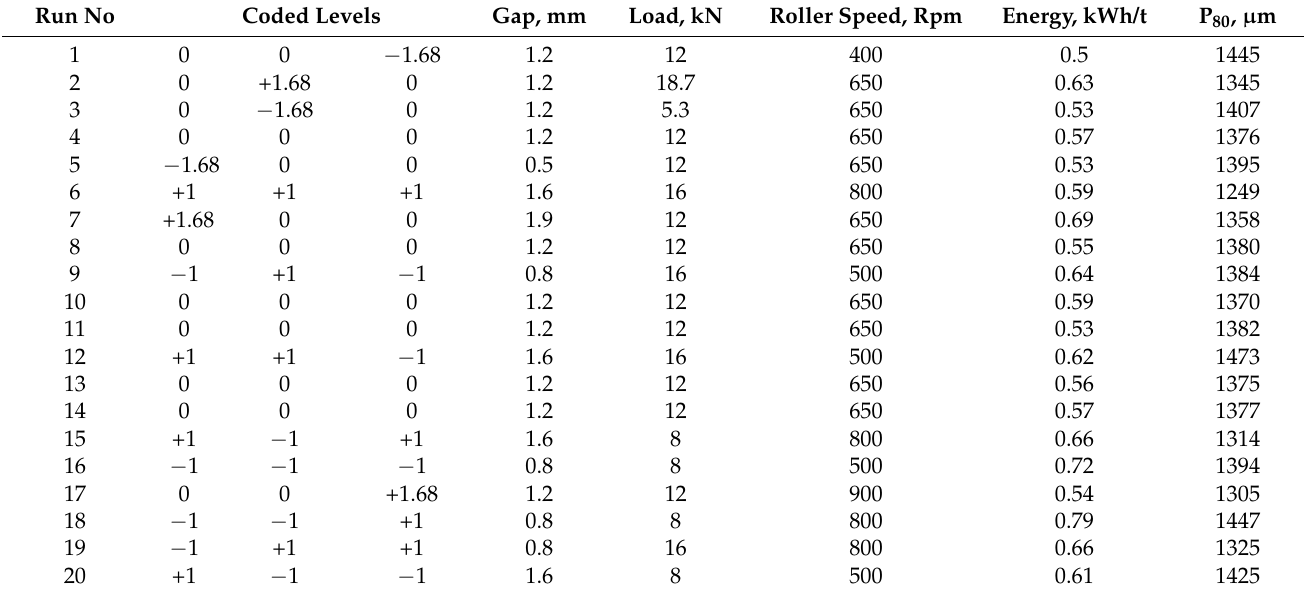
Table 2. Central composite design of independent variables expressed in coded and actual levels with